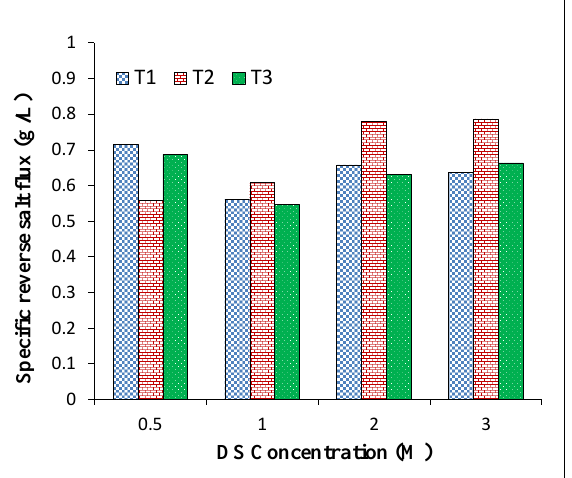
Figure 8. Membranes ’ performance in terms of specific reverse salt flux (SRSF) under the FO mode Figure 8. Membranes’ performance in terms of specific reverse salt flux (SRSF) under the FO mode with different NaCl molar concentrations as DS and DI water as FS. with different NaCl molar concentrations as DS and DI water as